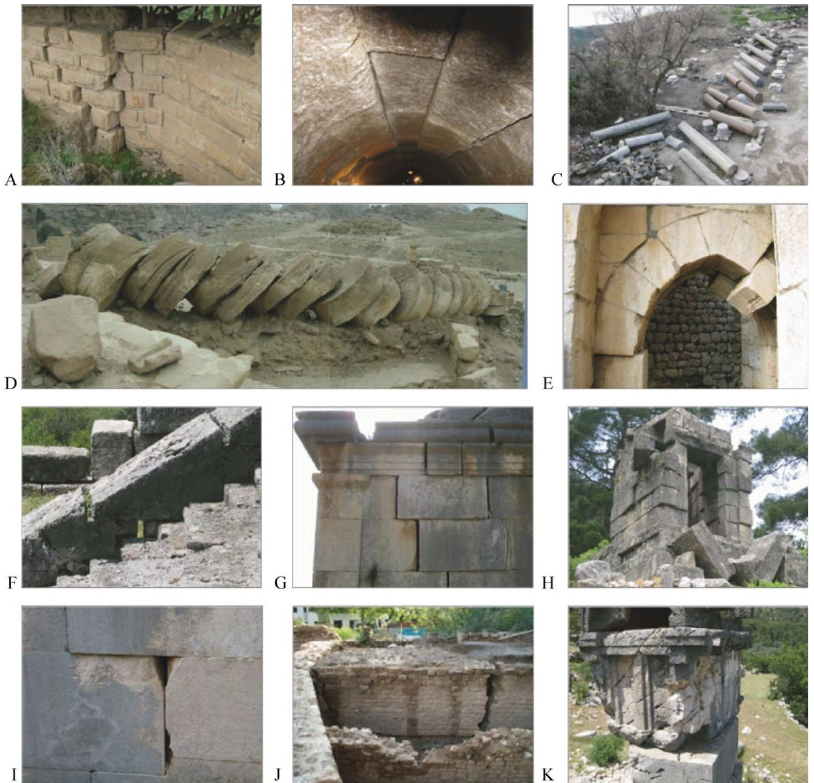
Figure 3. Examples of deformations and damage which are possibly earthquake effects: ( A ) the horizontally deformed wall of a crusader fortress built on top of the Dead Sea Transform Fault in the Jordan Valley; ( B ) the deformed vault of a Roman sewer in Cologne, Germany; ( C ) toppled columns of a Byzantine church in Sussita located above the Sea of Galilee; ( D ) toppled column of the great palace in Petra, Jordan; ( E ) moved block in an arch of the Nimrod fortress in the Golan Heights; ( F ) shifted blocks of an analemma of a Roman theatre in Pınara, SW Turkey; ( G ) moved blocks of a corner wall of a Roman monument in Patara, SW Turkey; ( H ) shifted blocks of a Roman grave house in Pınara, SW Turkey; ( I ) spall of block corners, same object as in ( G ); ( J ) broken and horizontally displaced fortification wall of the Roman Tolbiacum (Zülpich, Germany); ( K ) rotated Lycian sarcophagus in Pınara, SW Turkey. (Photos courtesy of K.G. Hinzen).